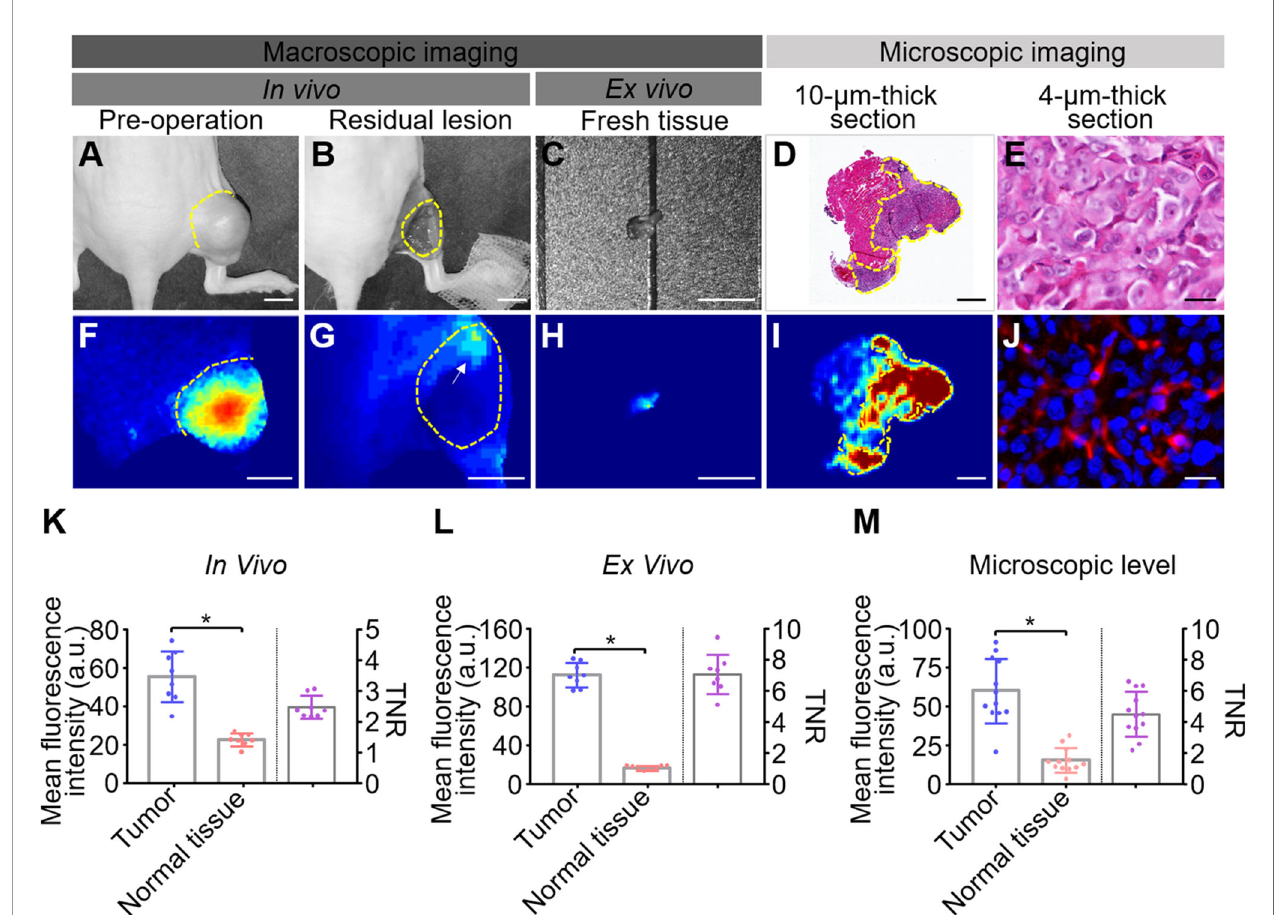
FIGURE 5 | Quantitative analysis of fl uorescence images from fl uorescence-guided surgery using HSA-ICG. (A – J) Correlation of fl uorescence signals with pathology during fl uorescence-guided surgery. (A, F) white-light images and corresponding fl uorescence images of MDA-MB-231 tumors prior to surgery. (B, G) the corresponding images of the surgical bed of residual cancer model under HSA-ICG guidance. The yellow arrow in (G) points to the local aggregated fl uorescence signal on the surgical bed. (C, H) ex vivo images of tissue resected from (B) . (D) hematoxylin and eosin staining of resected tissue, while (I) the corresponding fl uorescence image. (E, J) the tracer at much higher cellular resolution. (K – M) Quantitative analysis of fl uorescence signals of tumor and surrounding normal tissues in vivo (K) , ex vivo (L) , and in pathology slices (M) . Mean fl uorescence intensity of normal tissues (red) and tumor tissues (blue) is depicted on the left y-axis, while the right y-axis shows the mean fl uorescence intensity ratio of tumors to normal tissues. Tumors are outlined with a dashed line. Scale bars in all panels = 5 mm except (D, I) , where the scale bar = 500 µm; and (E, J) , where the scale bar = 25 µm. (paired Student ’ s t test, * P <